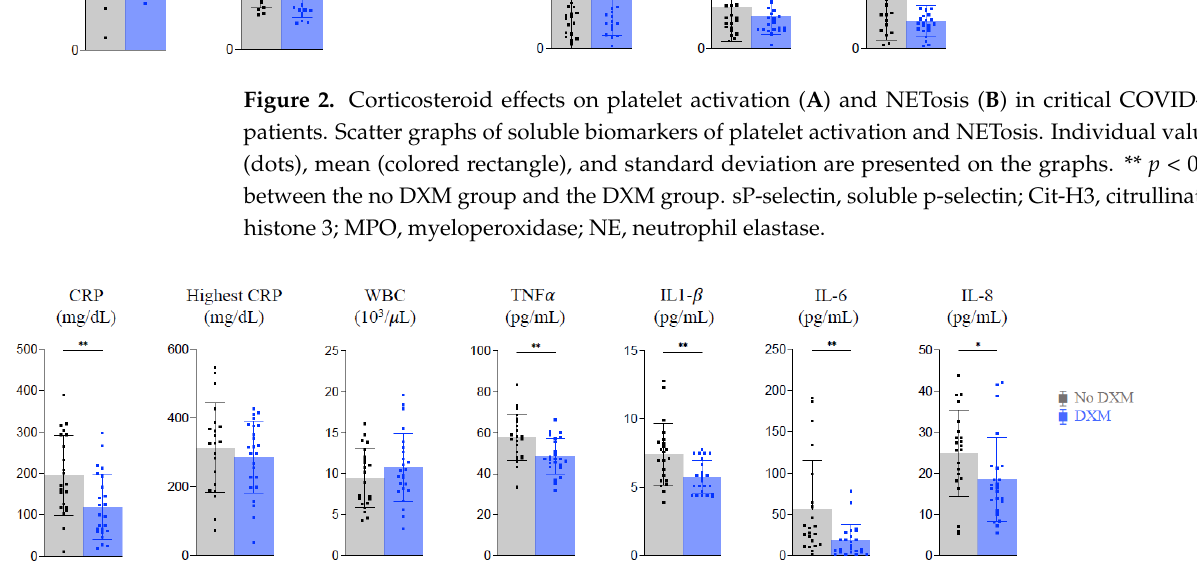
Figure 2. Corticosteroid e ff ects on platelet activation ( A ) and NETosis ( B ) in critical COVID-19 pa- tients. Sca tt er graphs of soluble biomarkers of platelet activation and NETosis. Individual values (dots), mean (colored rectangle), and standard deviation are presented on the graphs. ** p < 0.01 between the no DXM group and the DXM group. sP-selectin, soluble p-selectin; Cit-H3, citrullinated histone 3; MPO, myeloperoxidase; NE, neutrophil elastase.